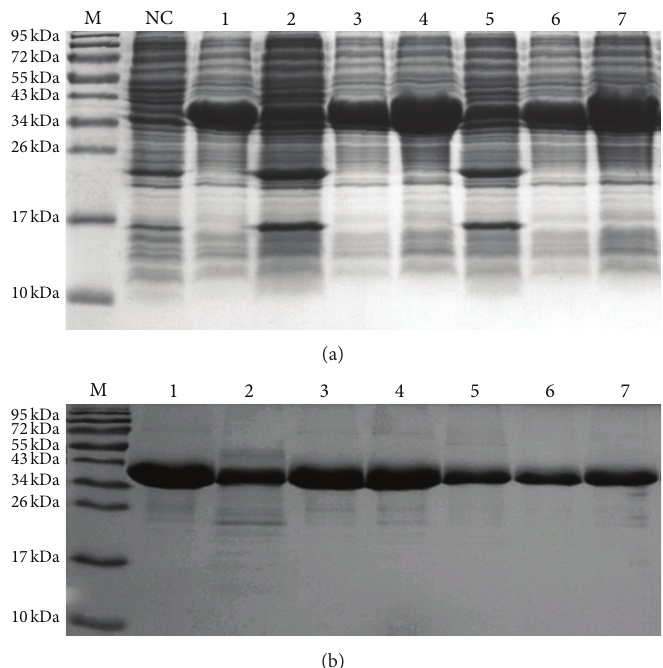
Figure 2: Expression and purification of B. abortus MDH and the six mutant forms were identified with SDS-PAGE followed by Coomassie blue staining. (a) SDS-PAGE profiles of the expressed recombinant proteins. Lane M: prestained protein marker (SM0671, Fermentas); lane NC: total cellular proteins of E. coli BL21 transformed with pET-28a. No band of 38 kDa His-MDH was shown. Lane 1: total cellular proteins of E. coli BL21 transformed with expression plasmids pET-28a-MDH. Lanes 2–7: total cellular proteins of E. coli BL21 transformed with pET-28a-derived plasmids containing the mutant forms of the mdh gene, including Arg 89 to Leu mutant, Asp 149 to Val mutant, Arg 152 to Leu mutant, His 176 to Pro mutant, Asp178 to Val mutant, and Thr 231 to Val mutant, respectively. (b) Coomassie blue staining of the expressed recombinant proteins. Lane M: prestained protein marker (SM0671, Fermentas). Lane 1: purified proteins of MDH. Lanes 2–7: purified proteins of mutant forms MDH, including Arg 89 to Leu mutant, Asp 149 to Val mutant, Arg 152 to Leu mutant, His 176 to Pro mutant, Asp178 to Val mutant, and Thr 231 to Val mutant, respectively.